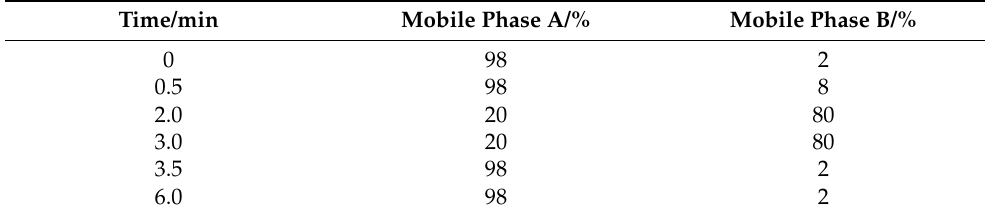
Table 4. Gradient elution program of the target